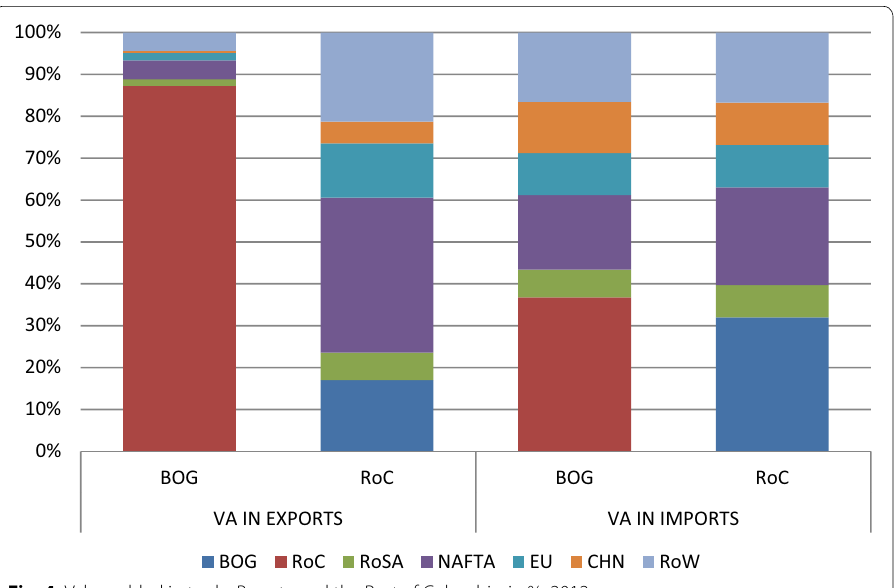
Fig. 4 Value added in trade, Bogota and the Rest of Colombia, in %,